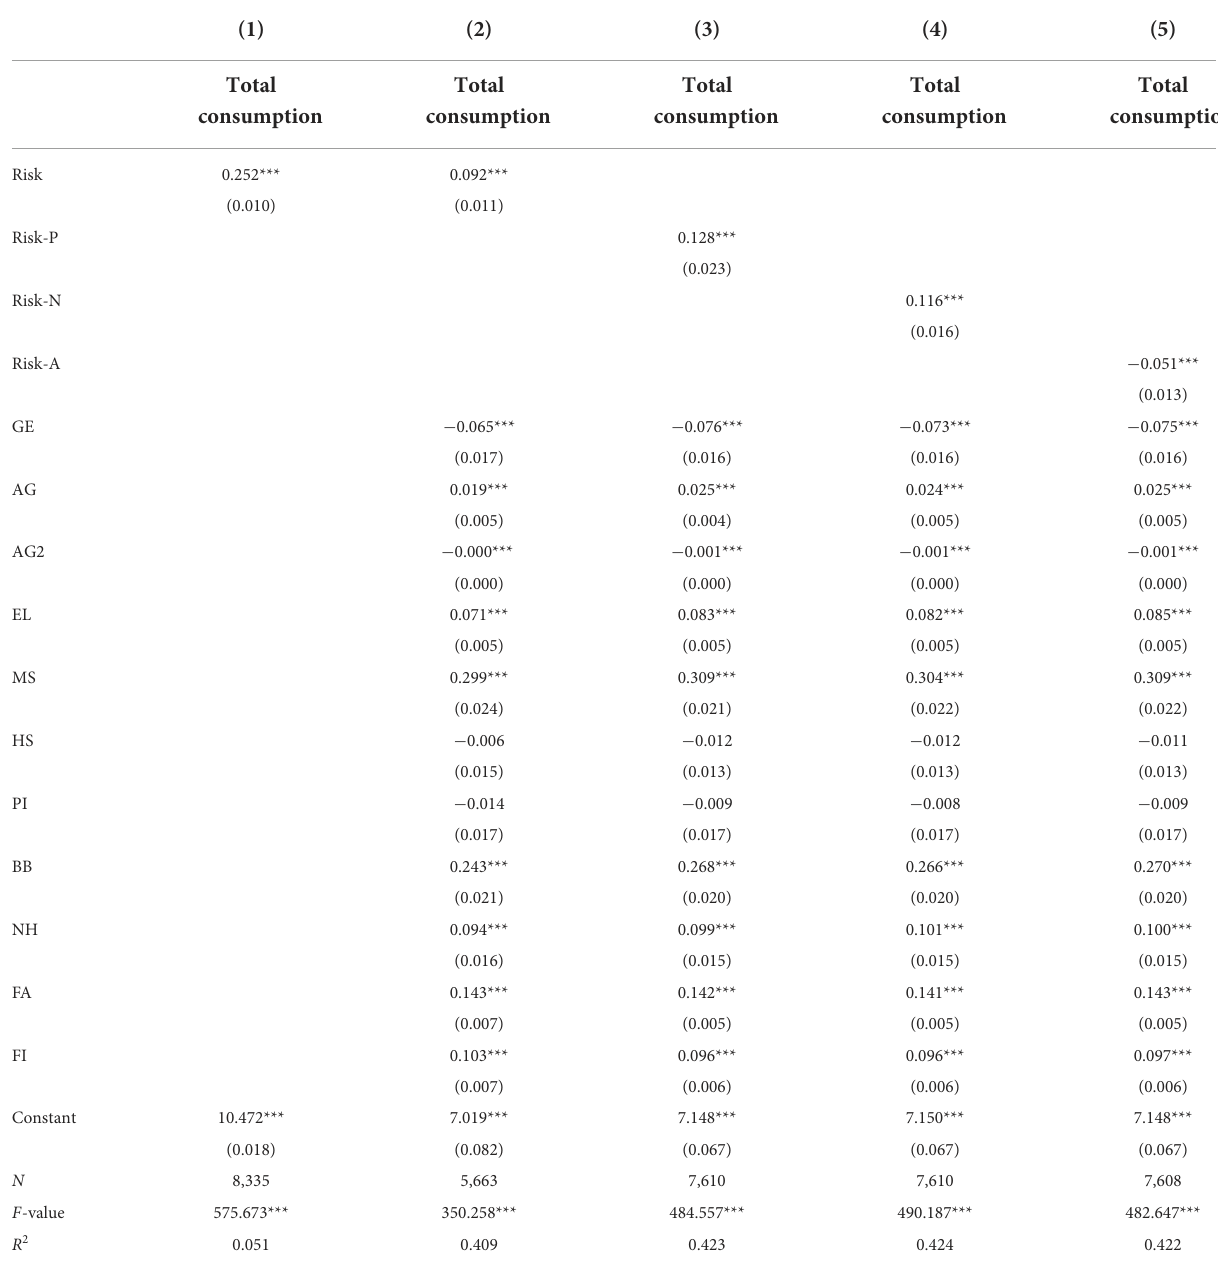
TABLE 10 The impact of risk attitude on household total consumption